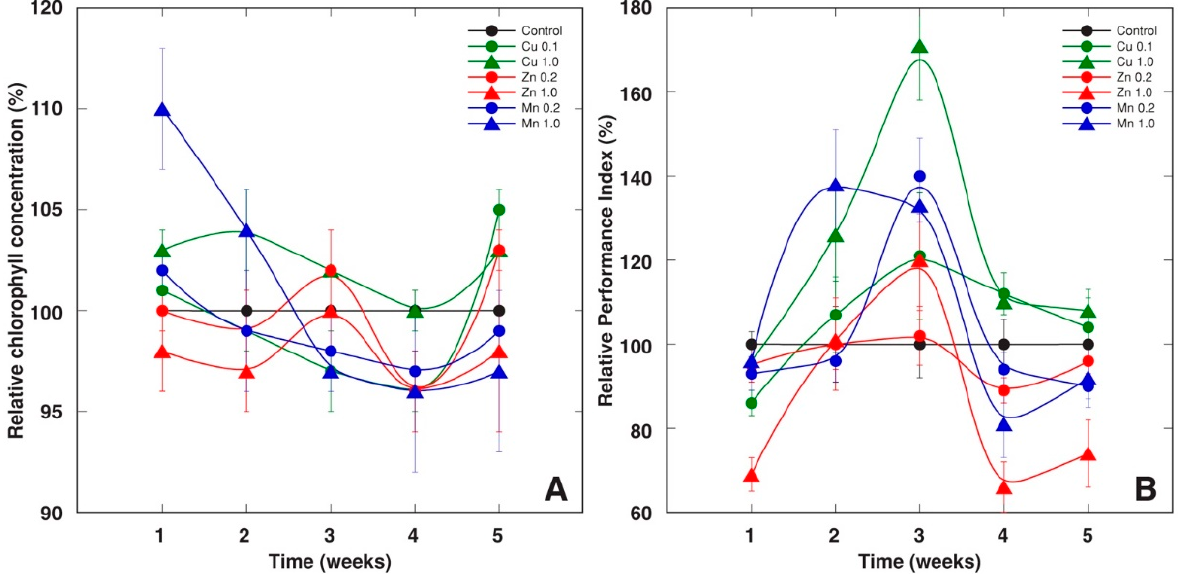
Figure 3. Effect of treatment with different concentrations of Cu, Zn, and Mn on changes in relative chlorophyll concentration ( A ) and Performance Index ( B ) in leaves of H. maximum (Experiment 1). Data are means ± SE from 5 replicates, each with 2 measurements, for each point.